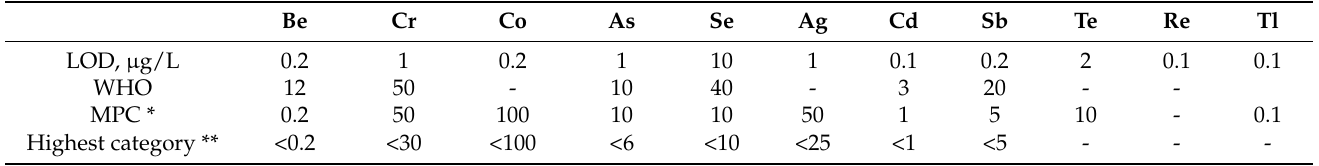
Table 5. The detection limits of chemical